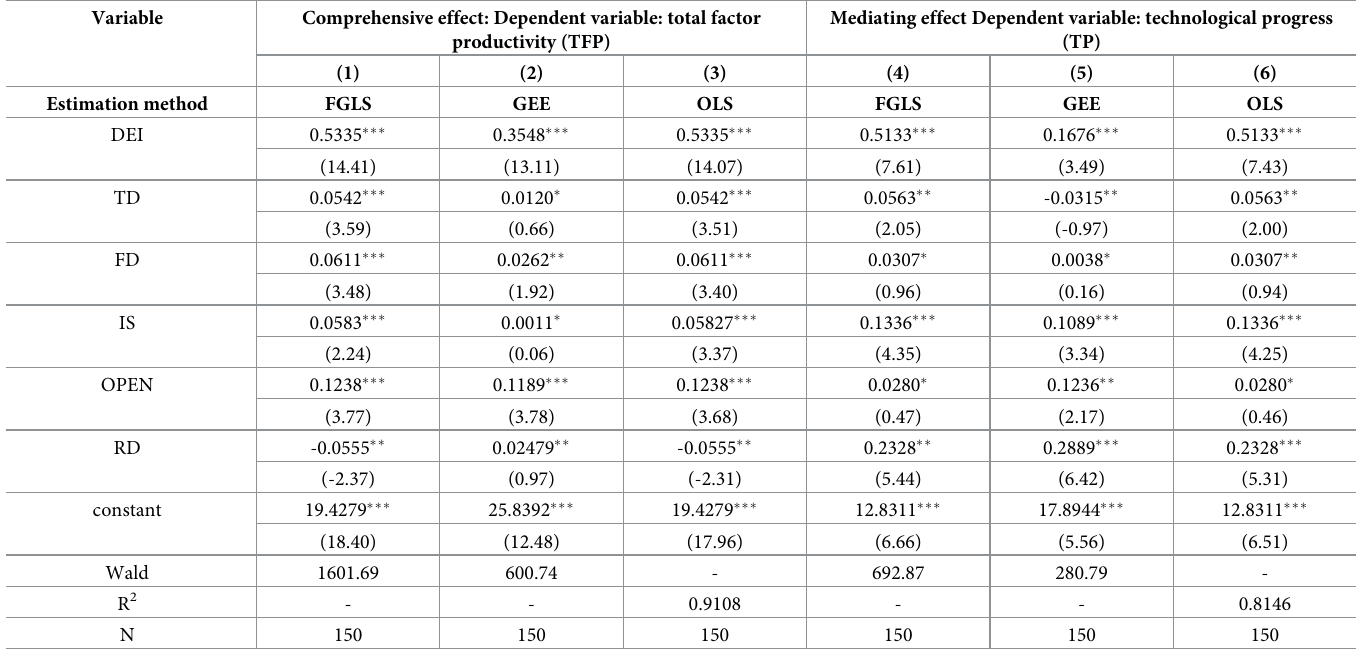
Table 7, columns (4)~(6) calculate the effect of the digital economy on the level of regional technological progress. The regression coefficients of FGLS, GEE and OLS are 0.5133, 0.1676 and 0.5335, respectively, and they all pass the significance test of 0.01. It can be seen that the influence of the development of the digital economy on the level of technological progress in the region is robust, and the results show that the development of the digital economy has a significant positive effect on improving the level of technological progress in the region.